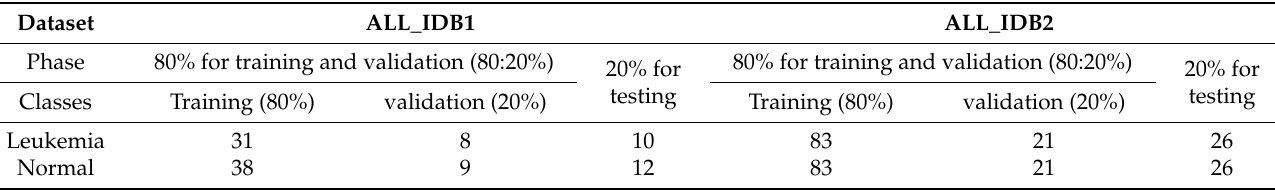
Table 1. Splitting the ALL_IDB1 and ALL_IDB2 datasets for training and